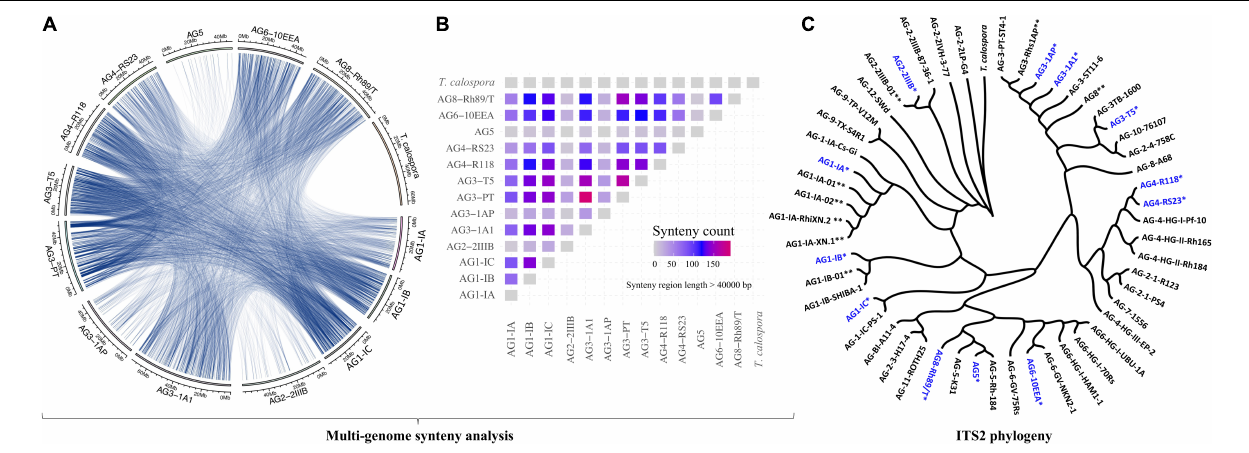
FIGURE 1 | (A) Circos plot. The Circos plot represents the syntenic relationship between genomes of different AGs of Rhizoctonia solani Kühn. Each line represents the region of genomic similarity predicted with Synima. Only the regions with coverage > 40,000 bases were enumerated and shown. (B) The plot highlights the number of high-similarity syntenic regions (coverage > 40,000 bp) shared between each pair of genomes, including T. calospora . The red connection represents corresponding isolates sharing a comparatively large number of syntenic relationships relative to other pairs of isolates. Here, self-hits were removed or not shown. (C) ITS2 phylogeny. ITS2 sequences of the tester strain were obtained from the NCBI database and were clustered with ITS2 sequences from assembled R. solani genomes (highlighted with blue color and *), along with ITS2 sequences from previously published R. solani genome assemblies (marked with **). The phylogenetic tree was constructed using megax software with 10,000 bootstrapping steps (see section “Materials and Methods”), after which the resulting tree and corresponding alignment were visualized together using